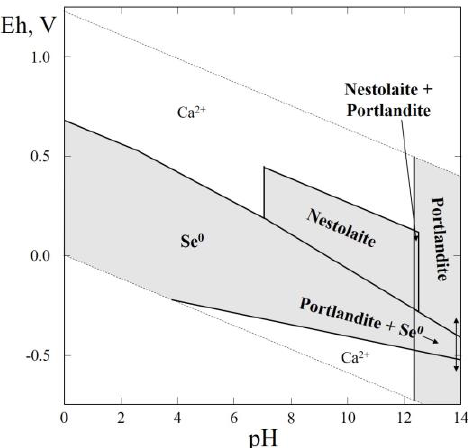
Figure 15. Eh–pH diagram of the OHSeCa (Ca–Se–H 2 O) system at 25 ◦ C and the activities of the Figure 15. Eh-pH diagram of the OHSeCa (Ca-Se-H 2 O) system at 25 °C and the activities of the components: a Σ Se = 10 − 4 , a Σ Ca = 10 − 2 components: a ΣSe = 10 − 4 , a ΣCa = 10 − 2 .